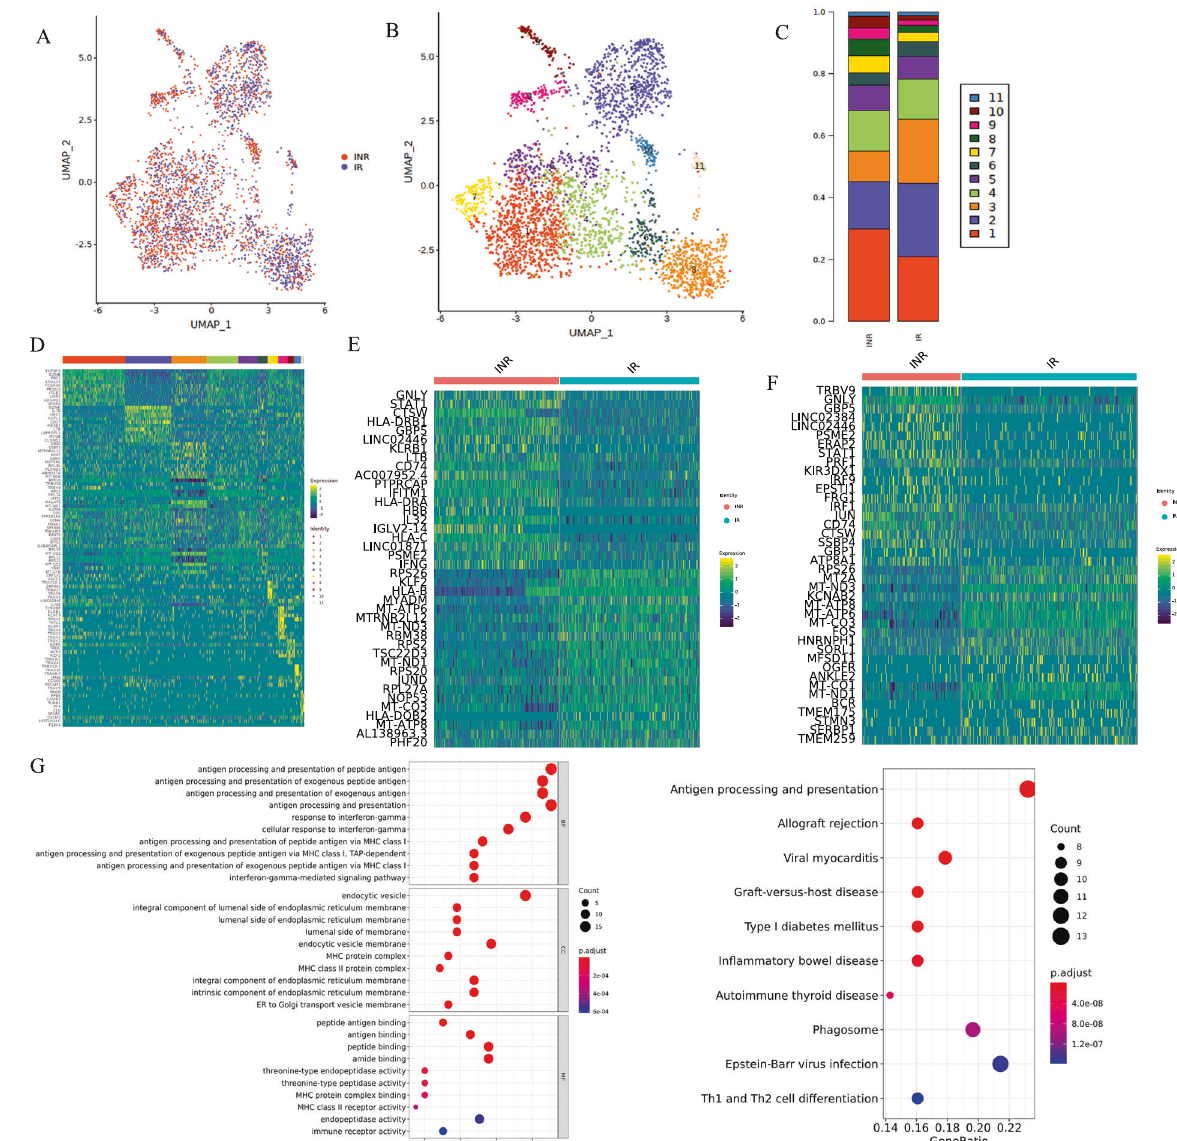
Fig. 6 Pro fi le of CD8 effector T cells in INRs. A UMAP visualization of CD8 effector T cells using the Seurat R package. Different colors represent two groups (left). Different colors represent different cell subsets (right) ( B ). C Proportion of CD8 effector T cells. D Differentially expressed genes in CD8 effector T cells between IRs and INRs ©. E Heatmap of top 40 genes signi fi cantly expressed in CD8 effector T C1. F Heatmap of top 40 genes expressed in CD8 effector T C2. G GO and KEGG were analyzed using DAVID for upregulated genes in CD4 CTL cells from INRs compared with